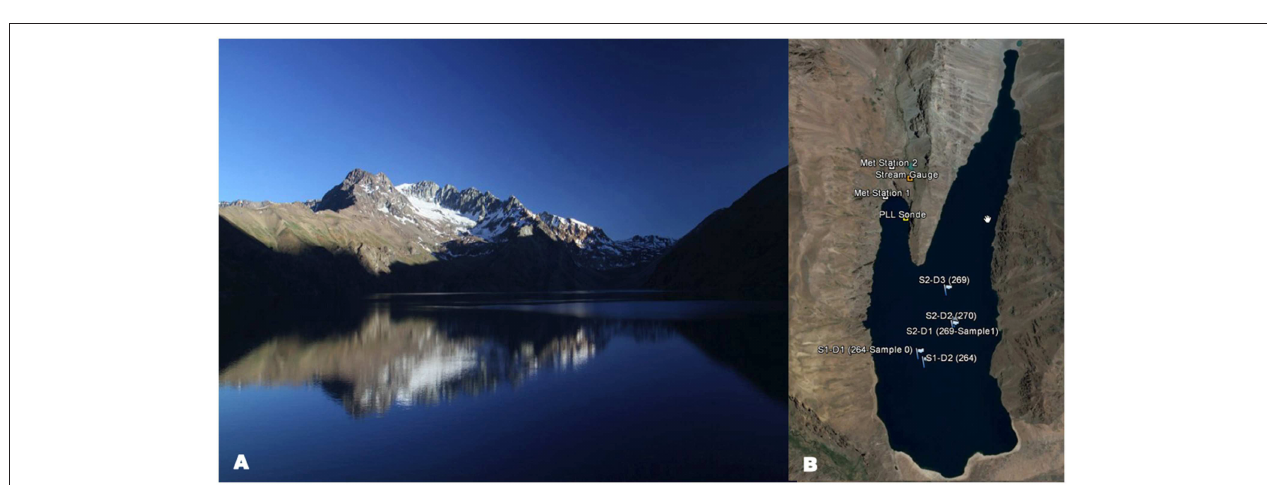
FIGURE 2 | Laguna Negra is located at an altitude of 2,700m on the south slope of the Echaurren glacier (in background of photo) watershed (33.65S/70.13W), where it constitutes part of the complex freshwater resources of the Santiago area (A) . A satellite image of the lake showing the locations of the water sampling sites (B)